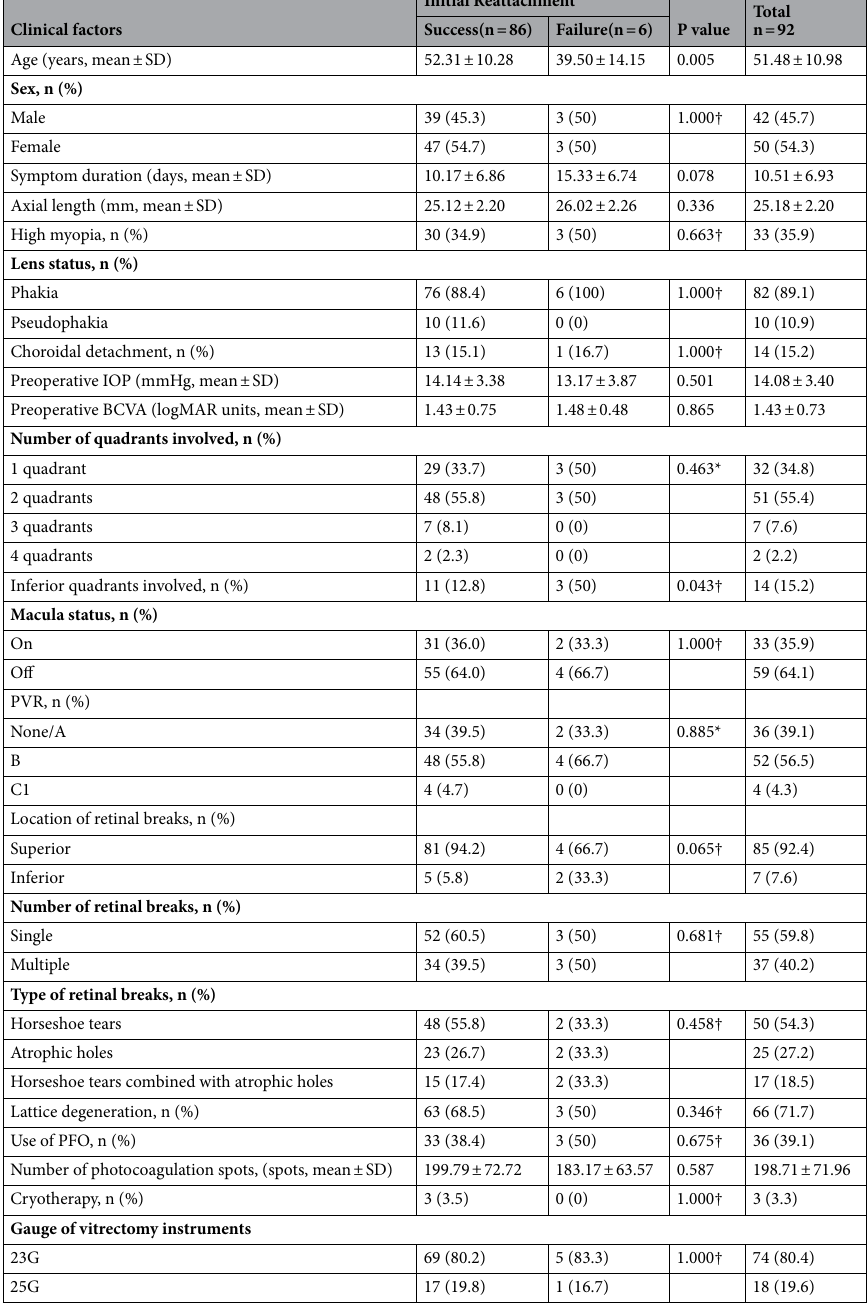
Table 1. Univariate Analysis Between Eyes with Success of Initial Reattachment and Eyes with Failure of Initial Reattachment After Primary Pars Plana Vitrectomy with Air Tamponade for Rhegmatogenous Retinal acuity; logMAR, logarithm of the minimum angle of resolution; PVR, proliferative vitreoretinopathy; PFO,